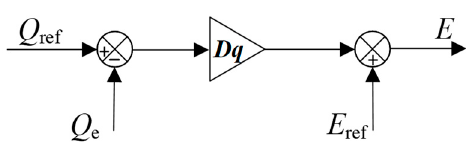
Figure 1. Basic VSG control diagram. Figure 2. Voltage and reactive power control of VSG.